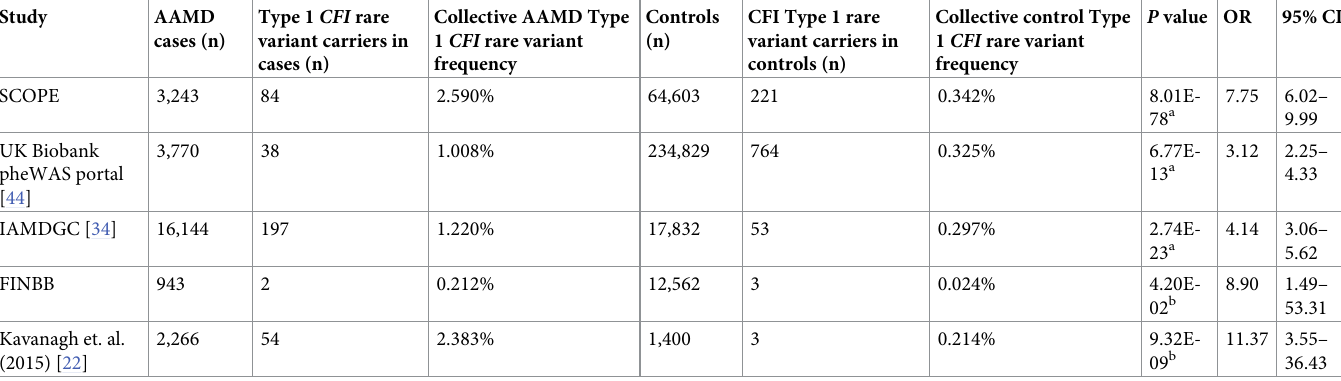
Table 1. Type 1 CFI rare variants are collectively enriched in European AAMD